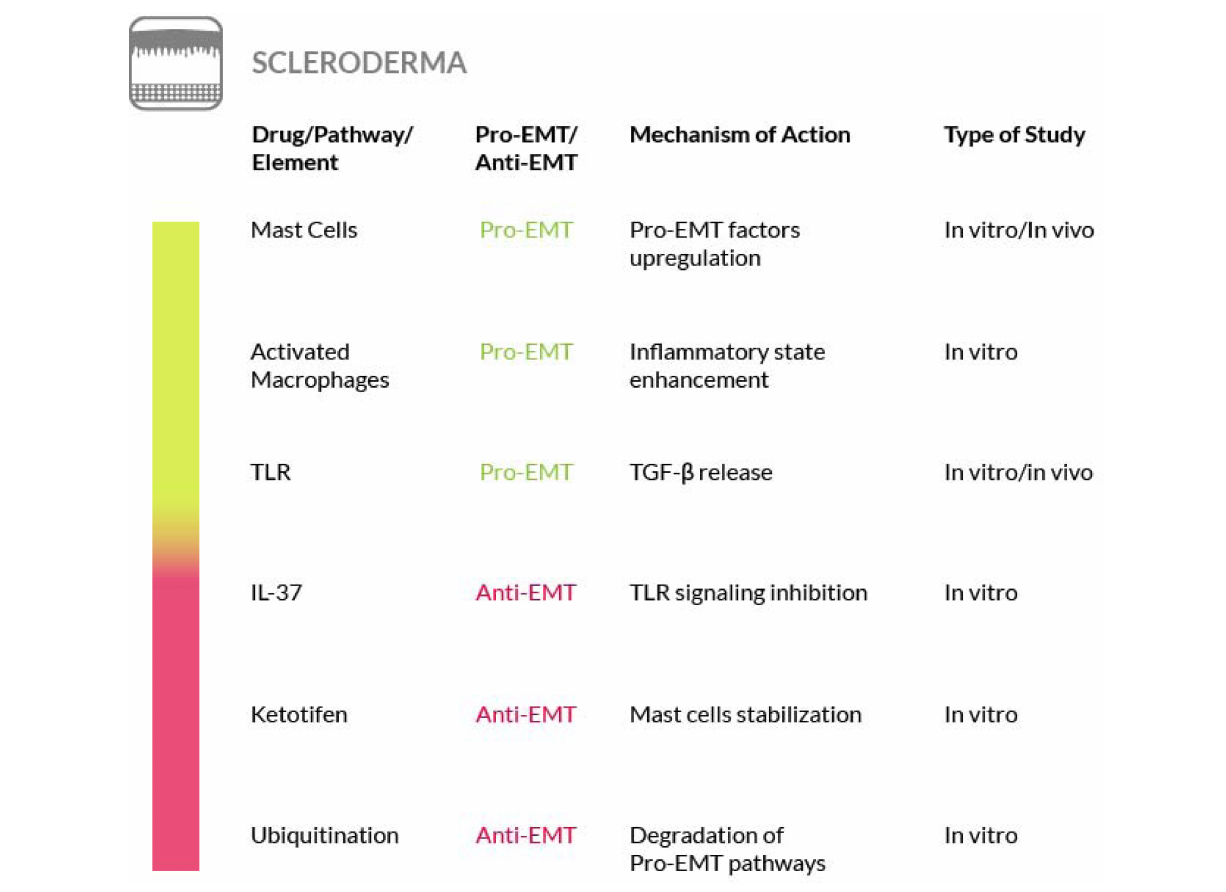
FIGURE 9 | Most relevant molecular mechanisms and possible drugs for the treatment of EMT in